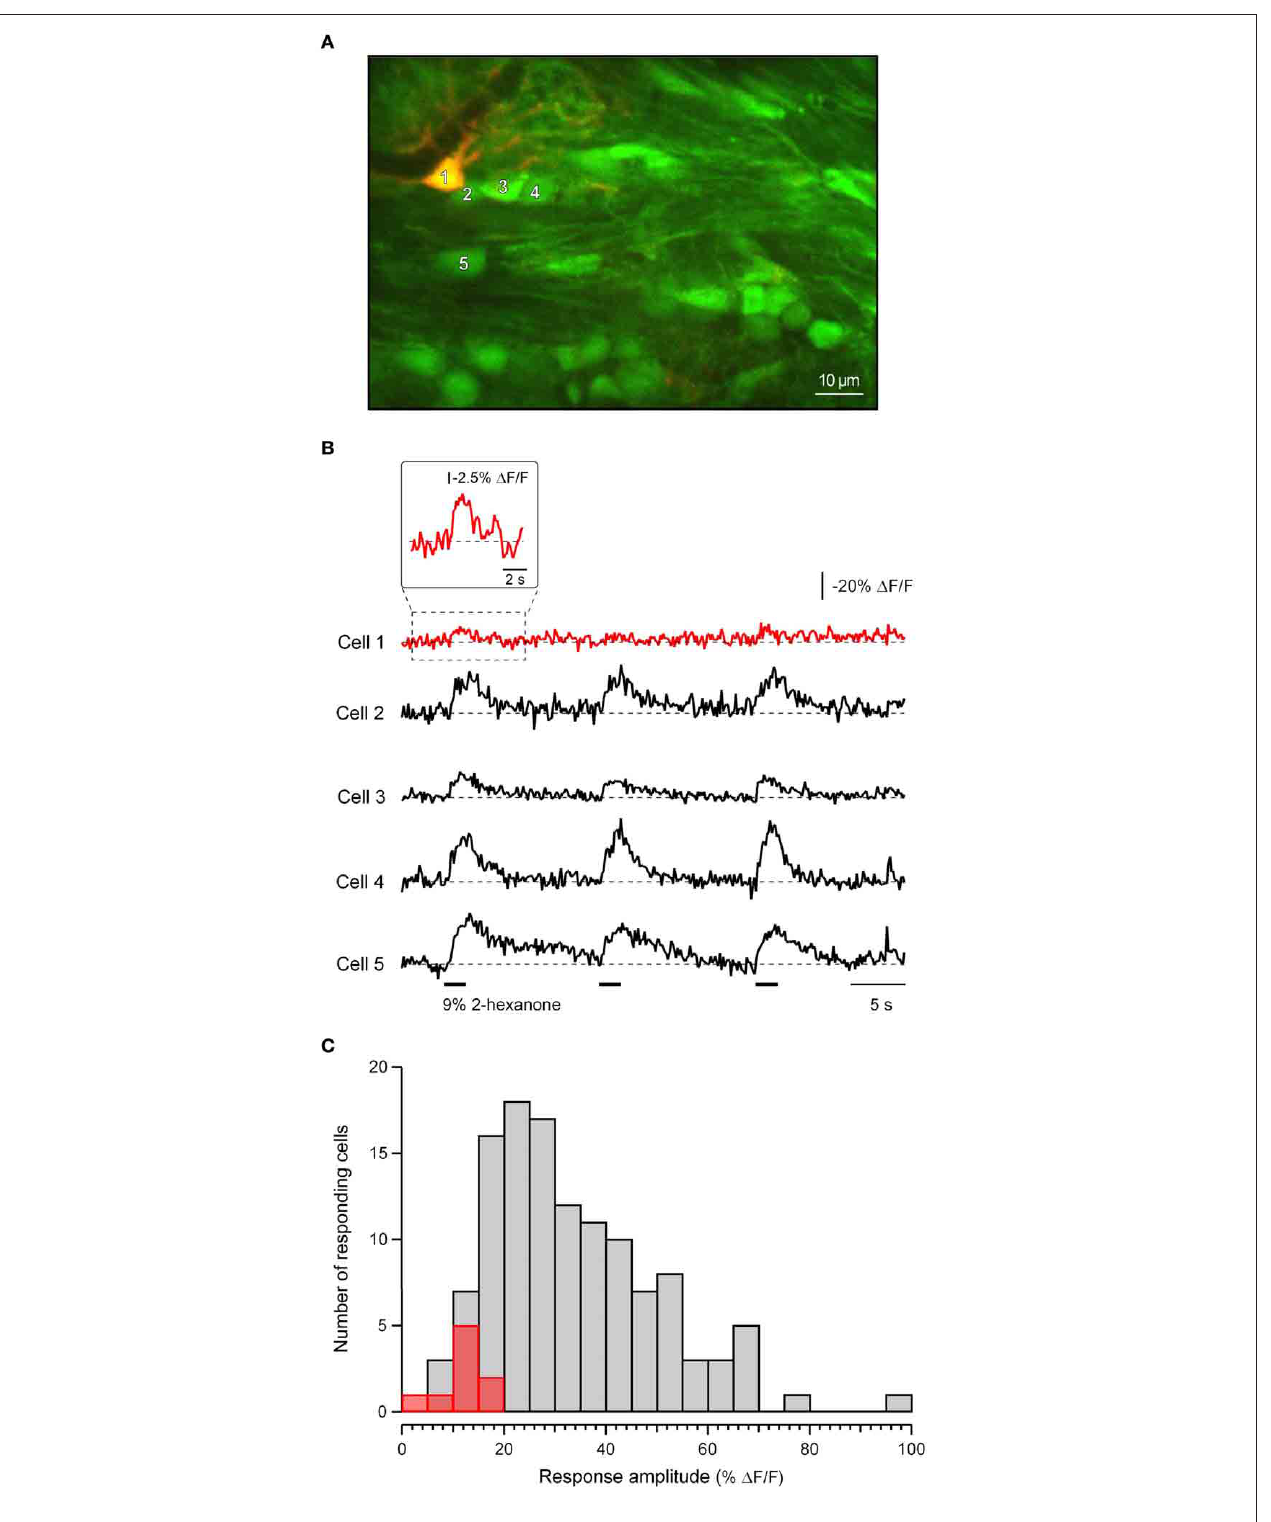
cell 1 is an expansion of the boxed portion of the trace temporally smoothed with a binomial (1-2-1) low-pass filter. (C) Distribution of the amplitudes of odor-evoked responses of nine identified glial cells (red) and an additional 122 mRFP1/AmCyan1-negative cells from the same frames (gray). No odorant responses were detected in additional 22 glial